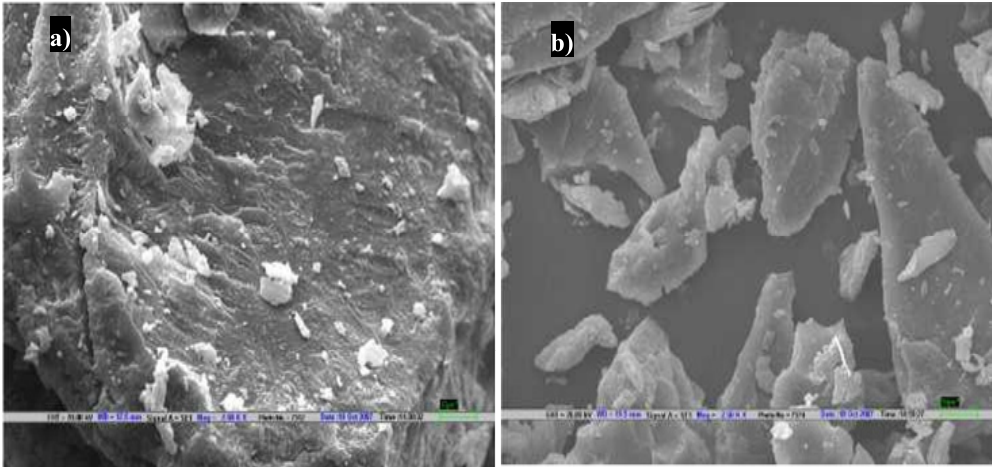
Figure 2. Scanning electron micrograph of ( a ) sterculia gum and ( b ) sterculia- cl -poly(MAAc) [28] (reproduced with permission from Elsevier). a)